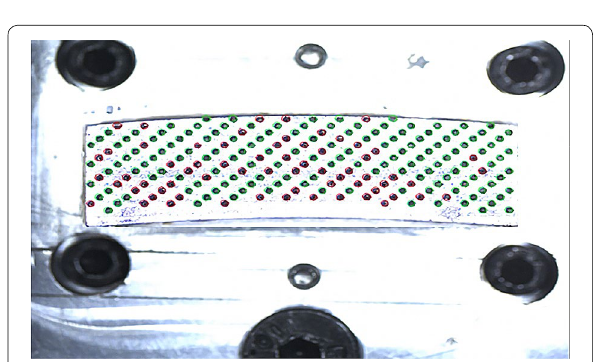
Figure 4 Image processing result of the machine vision system